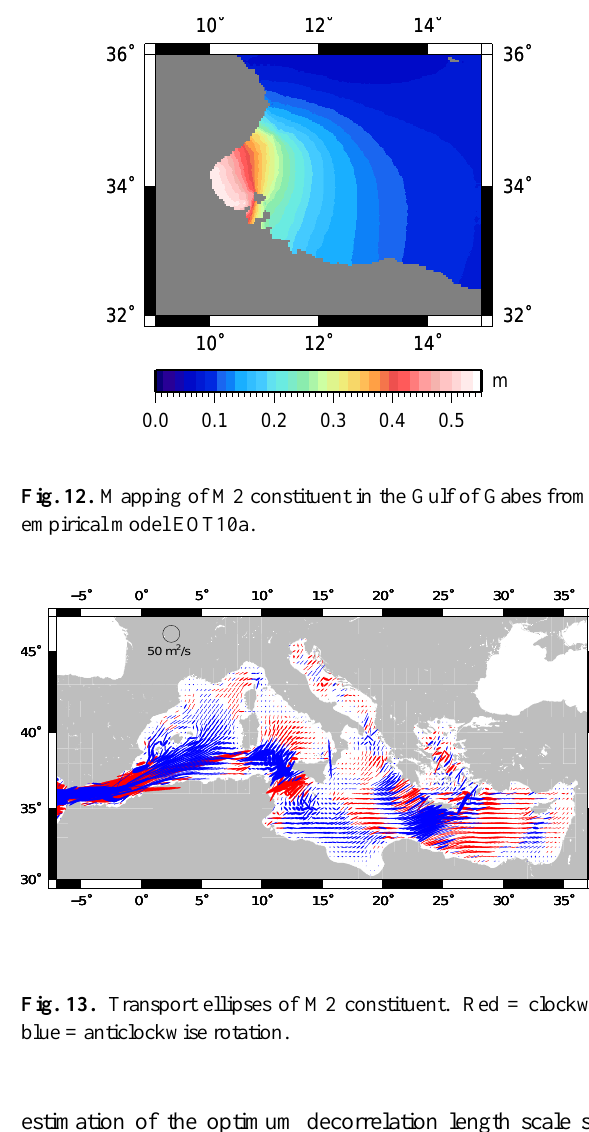
Fig. 11. Phase of the O1 constituent (degrees relative to UTC).